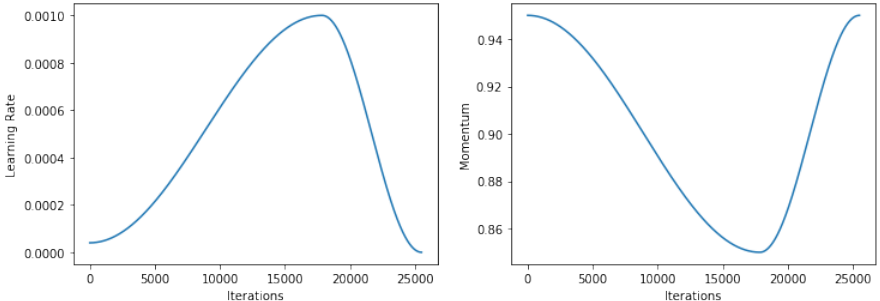
Figure 11. Learning rate and momentum values along iterations using one-cycle learning